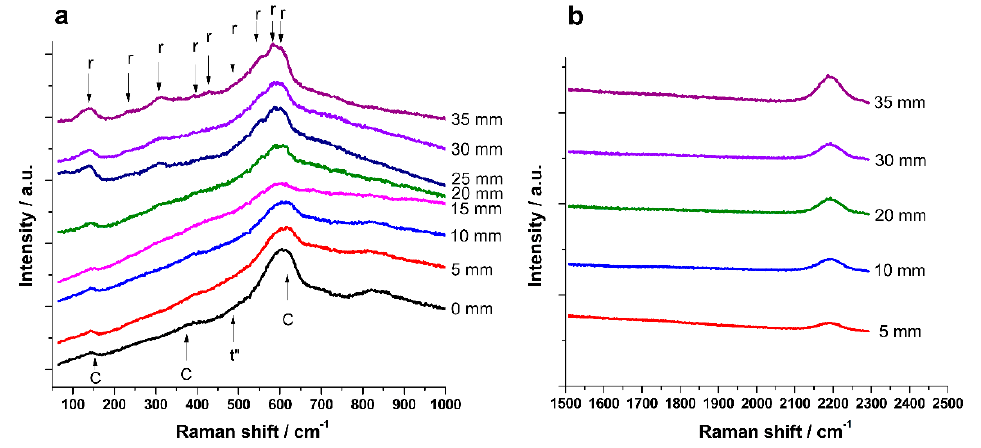
Figure 3. Raman spectra along as-grown 10Sc1CeSZ crystal.